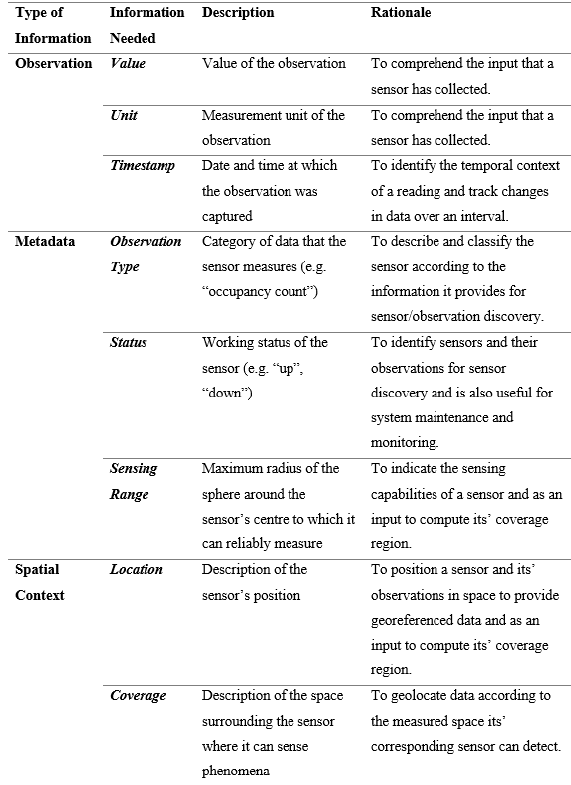
Table 2. Description of sensor properties to be used in the conceptual framework